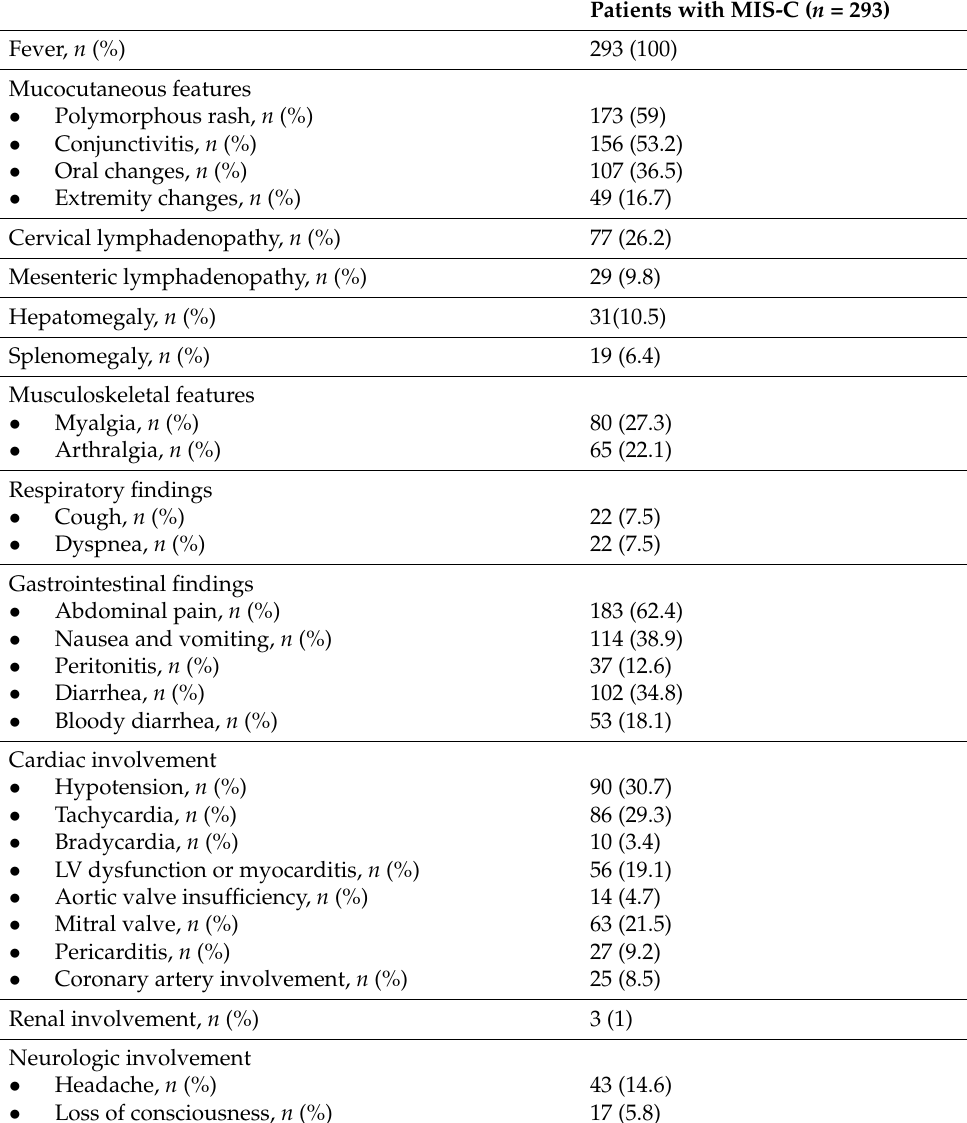
Table 1. Clinical characteristics of MIS-C